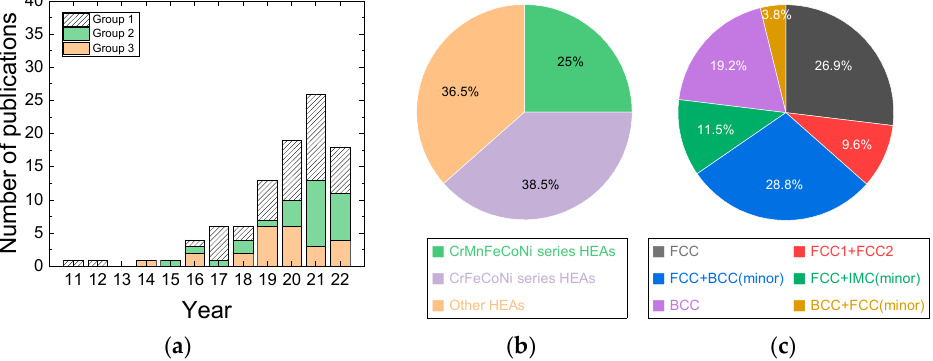
Figure 1. ( a ) Papers published in the literature from 2011 are categorized into three groups. The first group of papers includes papers that report hot compressive deformation of the HEAs in the limited temperature and strain rate range, the second group of papers provides hot compression data of the HEAs over a wide range of temperature and strain rates, but processing maps are not constructed, and the third group of papers provides hot compression data (over a wide range of temperature and strain rates) as well as processing maps of the HEAs. ( b ) Three material groups of HEA materials studied for hot compression, which are classified by their chemical compositions. ( c ) HEA materials studied for hot compression, which are classified by phases (crystal structures).